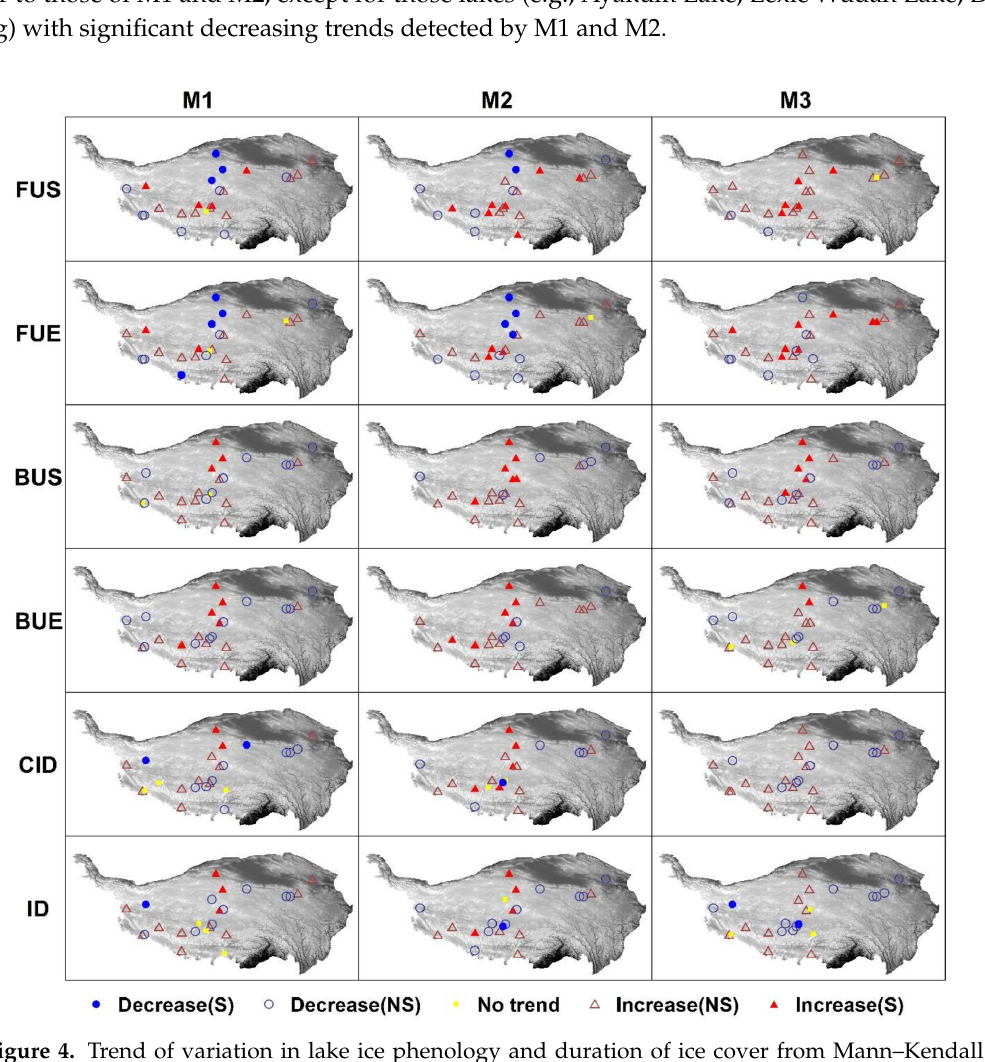
Figure 4. Trend of variation in lake ice phenology and duration of ice cover from Mann–Kendall test. Blue circle means earlier FUS/FUE/BUS/BUE and shortening CID/ID; red triangle means later FUS/FUE/BUS/BUE and extended CID/ID. Solid circle or triangle means the trend is statistically significant and the confidence level is 95%, while hollow circle or triangle means no significant trend. Yellow squares represent no